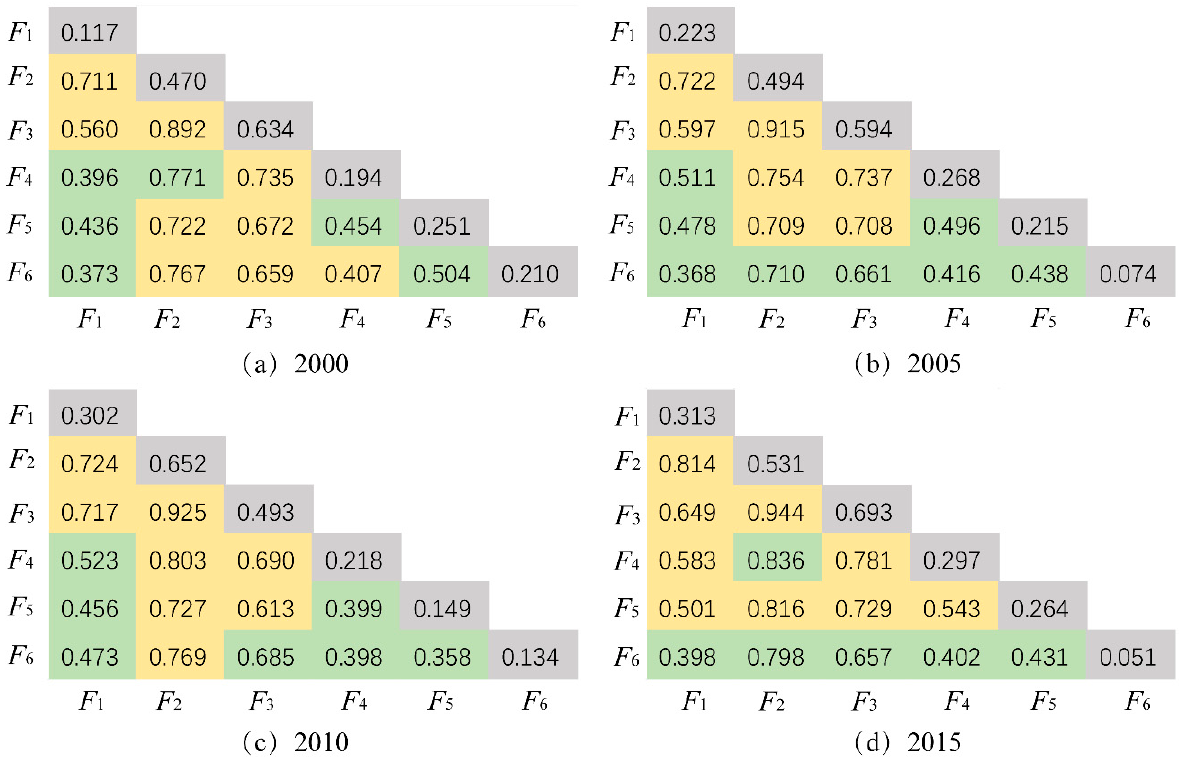
Figure 8. Interactive detection results of state-designated poverty counties in China from 2000 to 2015 (from Figure 4a–d, respectively): Gray indicates single factor action, Orange indicates bivariate enhancement, and Green indicates nonlinear enhancement. The value of the q -statistic was significant at 5%